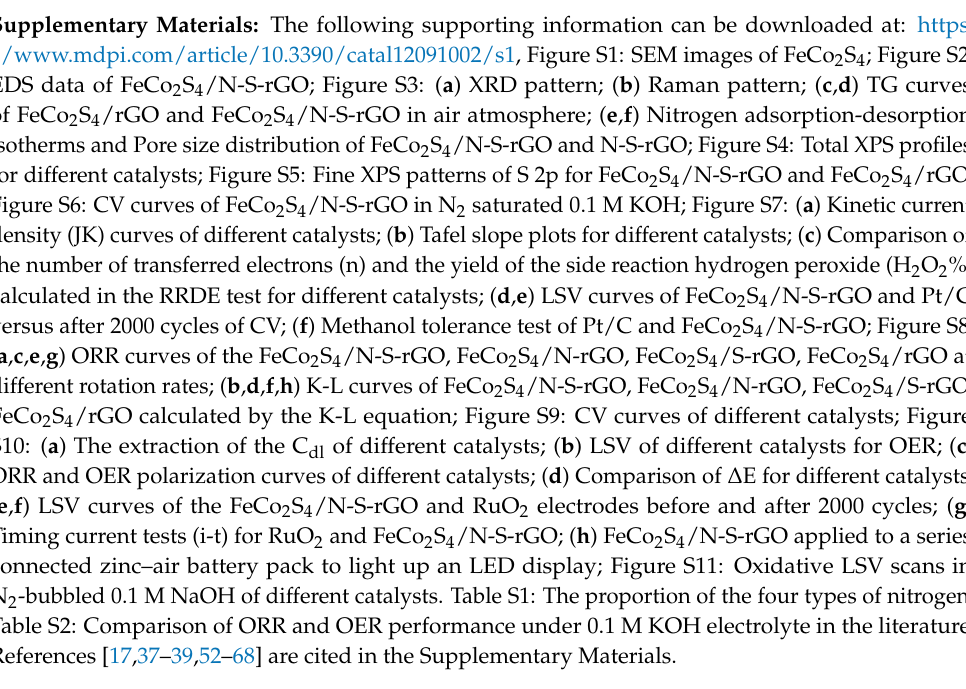
Figure S6: CV curves of FeCo 2 S 4 /N-S-rGO in N 2 saturated 0.1 M KOH; Figure S7: ( a ) Kinetic current density (JK) curves of different catalysts; ( b ) Tafel slope plots for different catalysts; ( c ) Comparison of the number of transferred electrons (n) and the yield of the side reaction hydrogen peroxide (H 2 O 2 %) calculated in the RRDE test for different catalysts; ( d , e ) LSV curves of FeCo 2 S 4 /N-S-rGO and Pt/C versus after 2000 cycles of CV; ( f ) Methanol tolerance test of Pt/C and FeCo 2 S 4 /N-S-rGO; Figure S8: ( a , c , e , g ) ORR curves of the FeCo 2 S 4 /N-S-rGO, FeCo 2 S 4 /N-rGO, FeCo 2 S 4 /S-rGO, FeCo 2 S 4 /rGO at different rotation rates; ( b , d , f , h ) K-L curves of FeCo 2 S 4 /N-S-rGO, FeCo 2 S 4 /N-rGO, FeCo 2 S 4 /S-rGO, FeCo 2 S 4 /rGO calculated by the K-L equation; Figure S9: CV curves of different catalysts; Figure S10: ( a ) The extraction of the C dl of different catalysts; ( b ) LSV of different catalysts for OER; ( c ) ORR and OER polarization curves of different catalysts; ( d ) Comparison of ∆ E for different catalysts; ( e , f ) LSV curves of the FeCo 2 S 4 /N-S-rGO and RuO 2 electrodes before and after 2000 cycles; ( g ) Timing current tests (i-t) for RuO 2 and FeCo 2 S 4 /N-S-rGO; ( h ) FeCo 2 S 4 /N-S-rGO applied to a series connected zinc–air battery pack to light up an LED display; Figure S11: Oxidative LSV scans in N 2 -bubbled 0.1 M NaOH of different catalysts. Table S1: The proportion of the four types of nitrogen; Table S2: Comparison of ORR and OER performance under 0.1 M KOH electrolyte in the